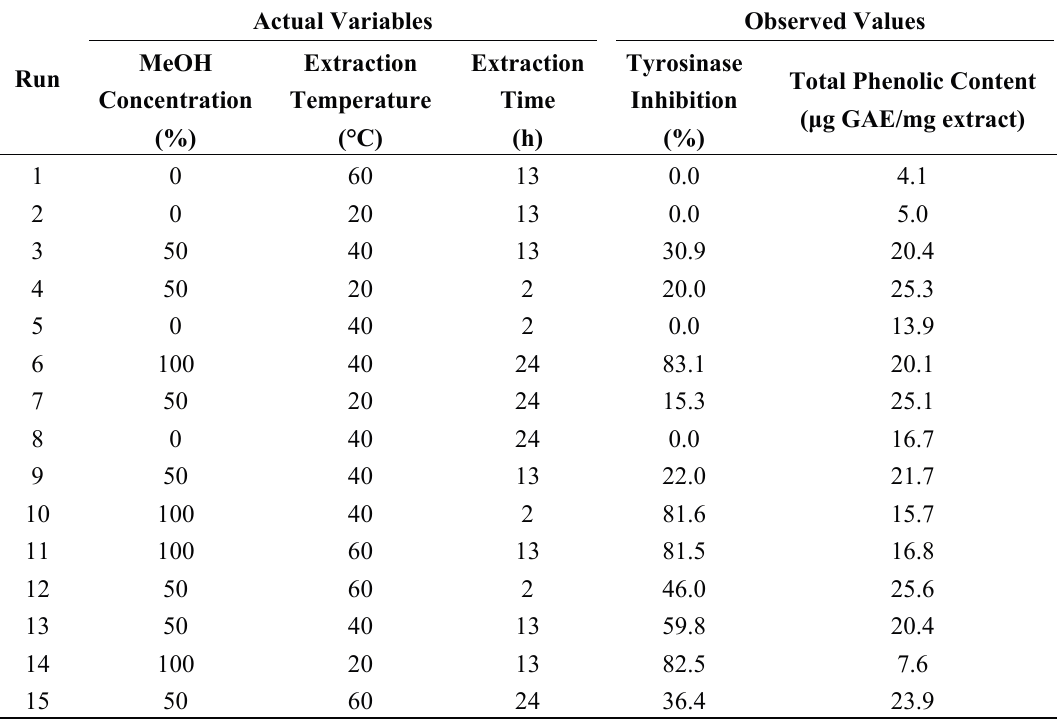
Table 1. A Box-Behnken design for independent variables and their